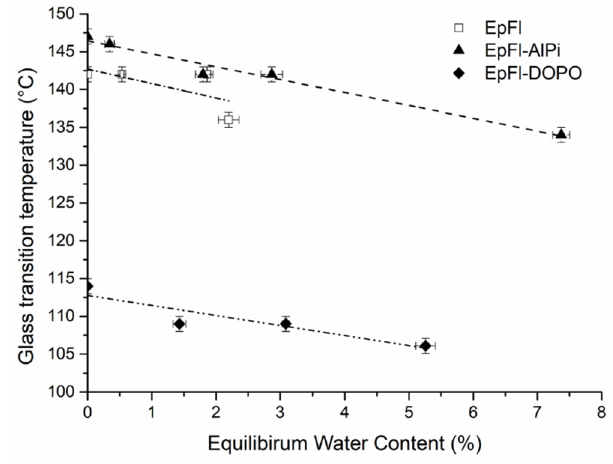
Figure 7. Glass transition temperature as a function of equilibrium water content.